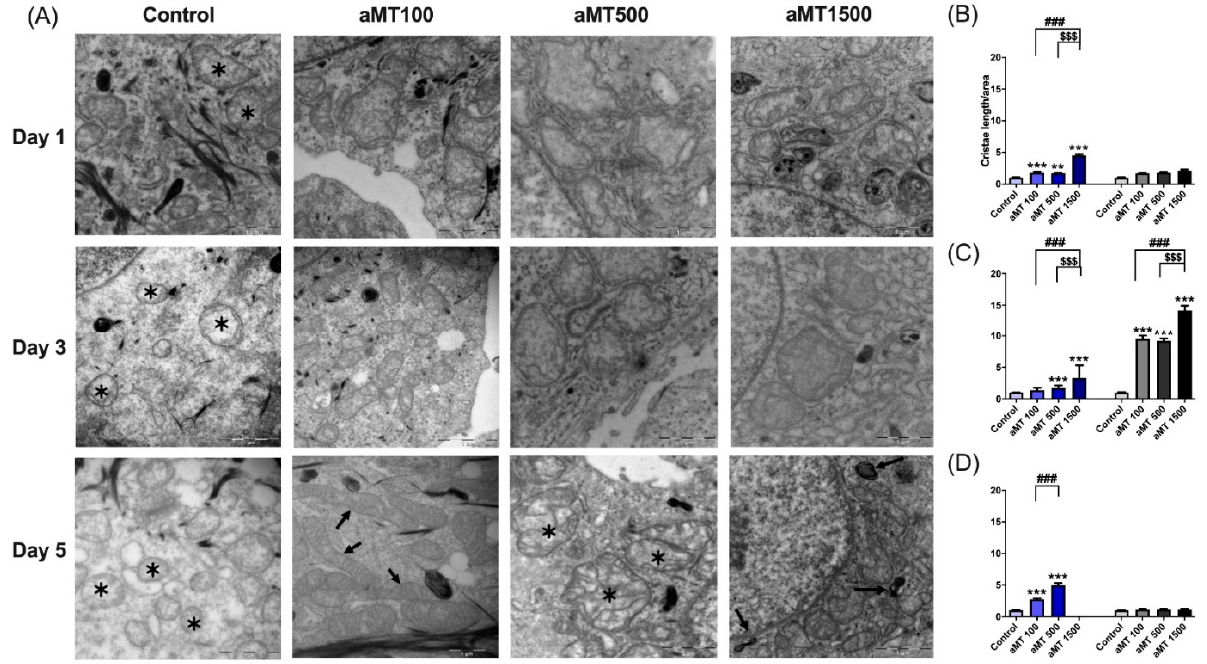
Figure 6. Melatonin-induced changes in mitochondrial morphology. Alterations in mitochondrial morphology analyzed by EM in Cal-27 cells ( A ), cristae length analyzed using the Image J software ( B – D ) in Cal-27 (in blue) and SCC-9 cells (in black and grey). In the control cells, the typical morphology of the Cal-27 mitochondria could be observed, with a round shape and few mitochondrial cristae (asterisks). No changes were detected over time. With aMT 100 concentration, mitochondria tend to get smaller and adopt elongated shapes, especially after 5 days of treatment (arrows). At dose of aMT 500, mitochondria do not show much change between day 1 and day 3, but at 5 days, mitochondria can be seen with a marked increase in cristae number (asterisks). At a concentration of 1500, at one day of treatment, mitochondria are similar to those in the control cells, although heterogeneous dense bodies are occasionally appreciated (arrows). After 3 days of treatment, the mitochondria maintain their shape and appearance, with abundant cristae. After 5 days, dense bodies continue to be seen (arrows) and it is difficult to detect cristae in some mitochondria. n = 6 per group. Data are presented as mean ± SEM. ** p < 0.01, *** p < 0.001 vs. control; ### p < 0.001 vs. aMT 100 µM group; $$$ p < 0.001 vs. aMT 500 µM group. Scale bar = 1 µm.